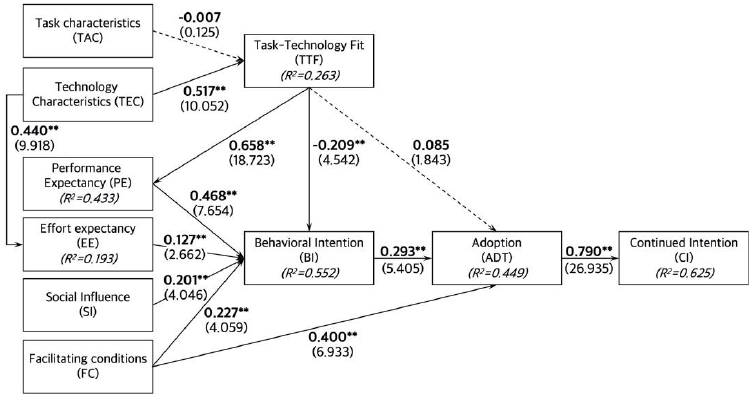
Figure 2. Structural model evaluation (** p < 0.01).